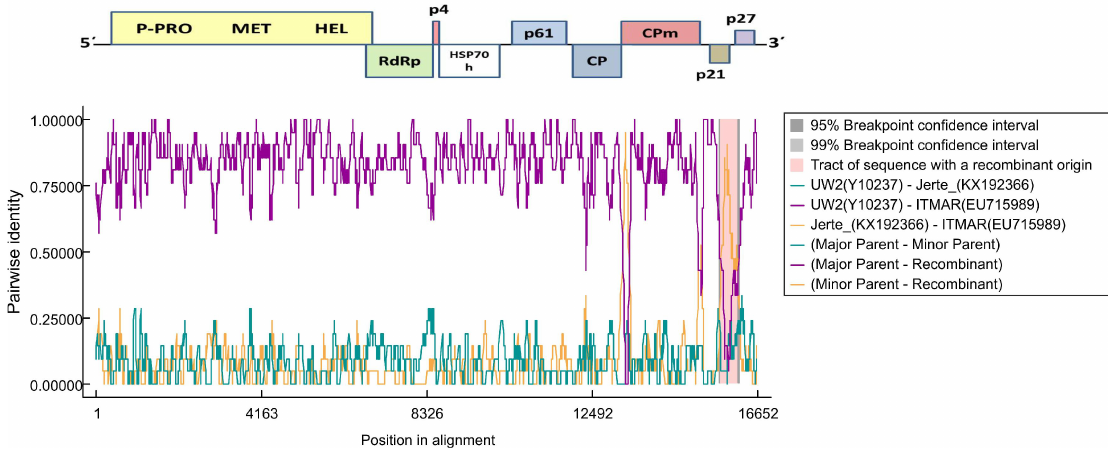
Figure 3. Recombination events predicted by RDP v.4.95 (Recombination Detection Program) in the 3′ end of the ITMAR isolate of LChV1. Lines in the graph give the pairwise identity percentage in the respective alignment position. The recombinant part is indicated by a frame and the breakpoints by darker background. LChV’s genome is given above the graph.